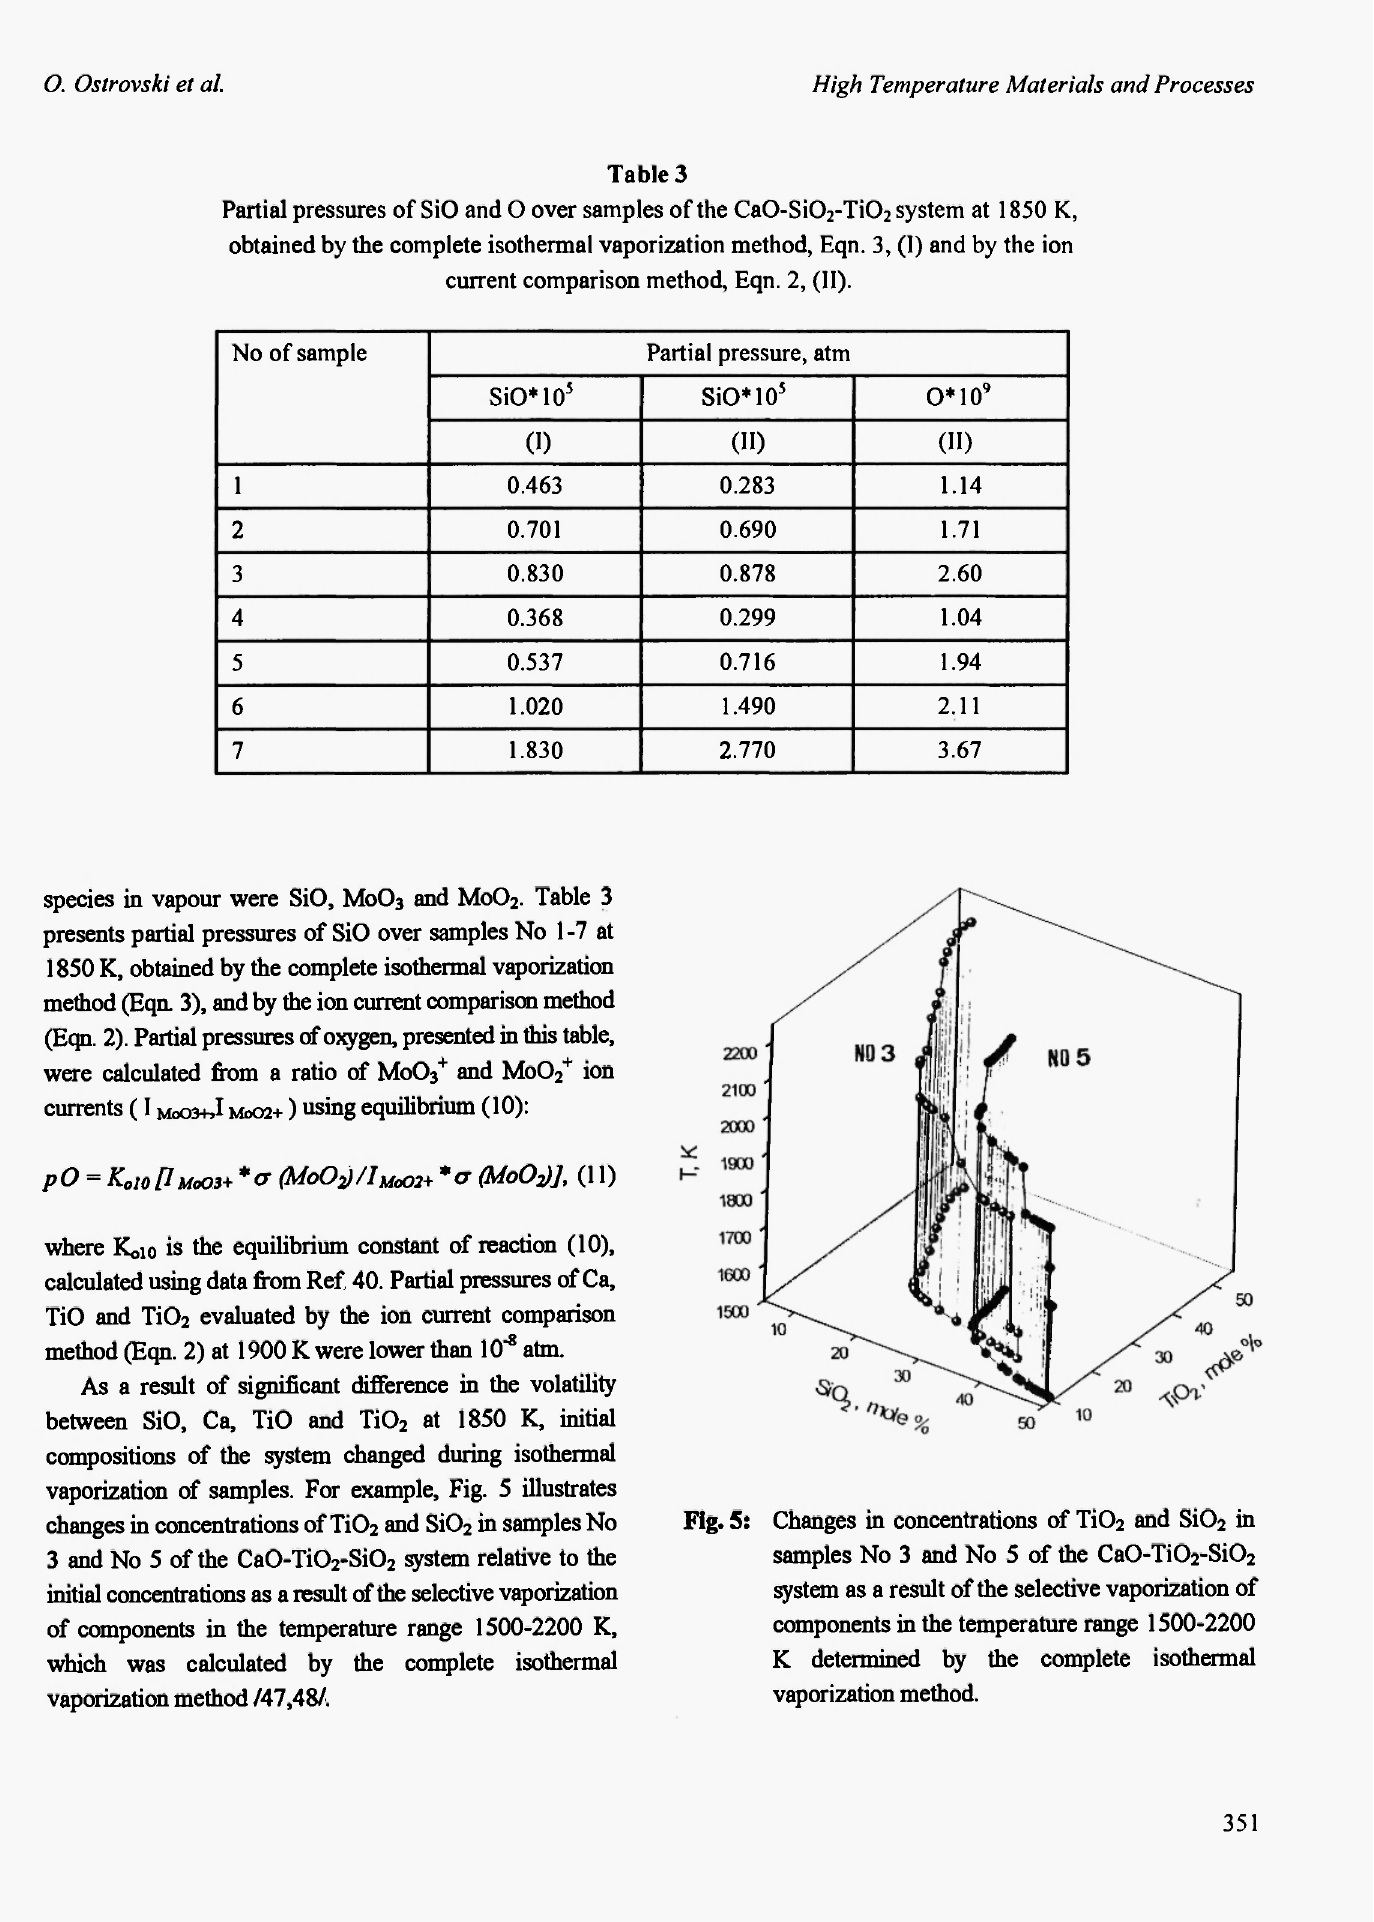
Fig. 5: Changes in concentrations of Ti0 samples No 3 and No 5 of the Ca0-Ti0 system as a result of the selective vaporization of components in the temperature range 1500-2200 Κ determined by the complete isothermal vaporization method.